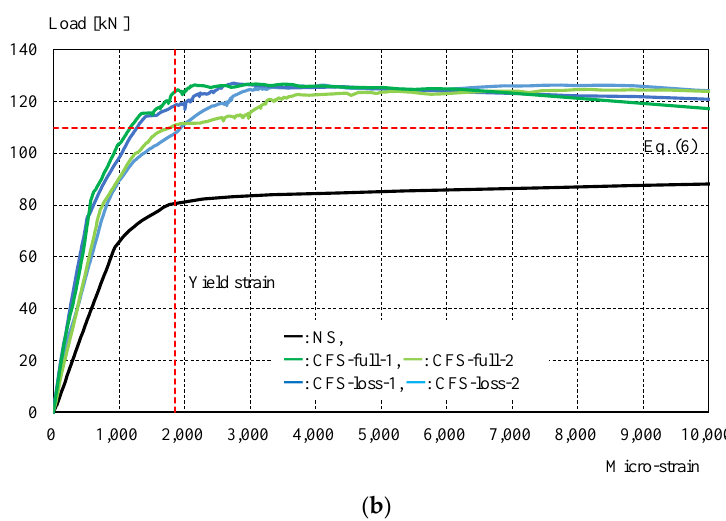
Figure 13. Load–strain (g1) relations: ( a ) a range of 0–10% strain; ( b ) a range of 0–1% strain.